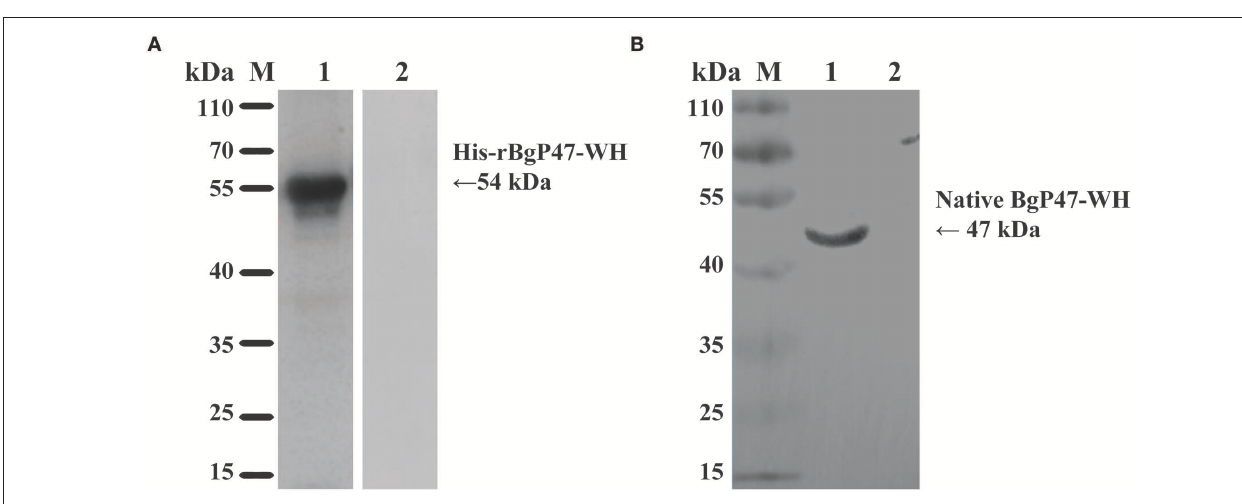
FIGURE 3 | Western blot analysis of BgGPI47-WH. (A) Determination of antibody response of rBgGPI47-WH in B. gibsoni -infected canine serum. Lane M: Molecular weight marker; lane 1: rBgGPI47-WH reacted with B. gibsoni -infected canine serum; Lane 2: rBgGPI47-WH was probed with normal serum from non-infected canine serum. (B) Identification of native BgGPI47-WH in B. gibsoni . Lane M: Molecular weight marker; lane 1: B. gibsoni -infected canine RBC lysates were probed with mouse anti-BgGPI47-WH serum; lane 2: Non-infected canine RBC lysates were probed with mouse anti-BgGPI47-WH